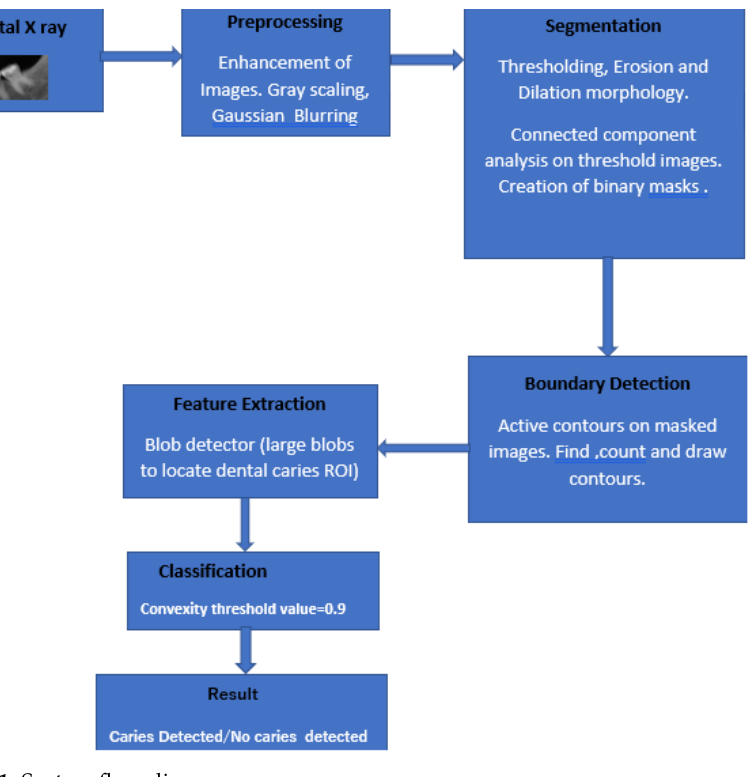
Figure 1. System flow